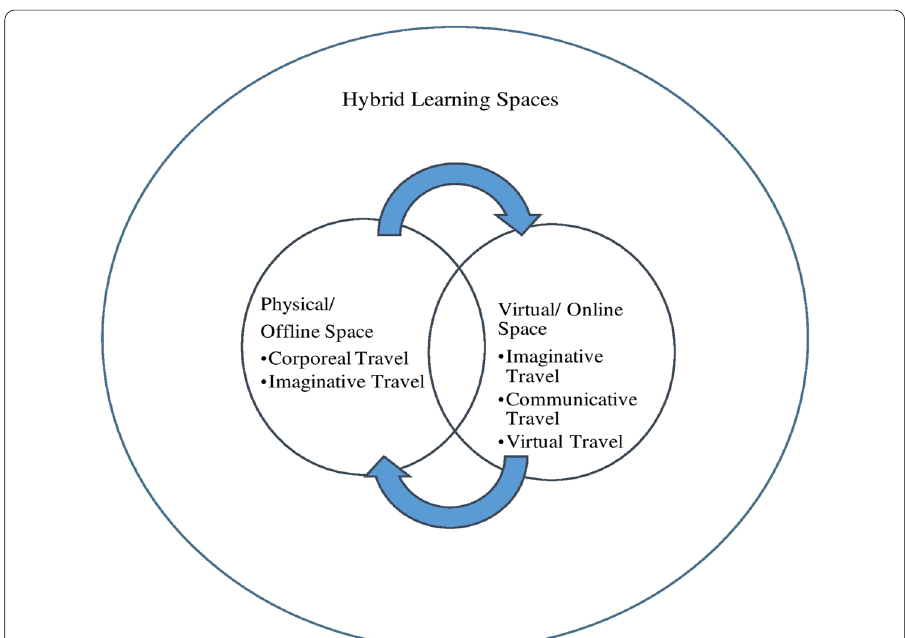
Fig. 5 Learners’ perceptions of the hybrid learning